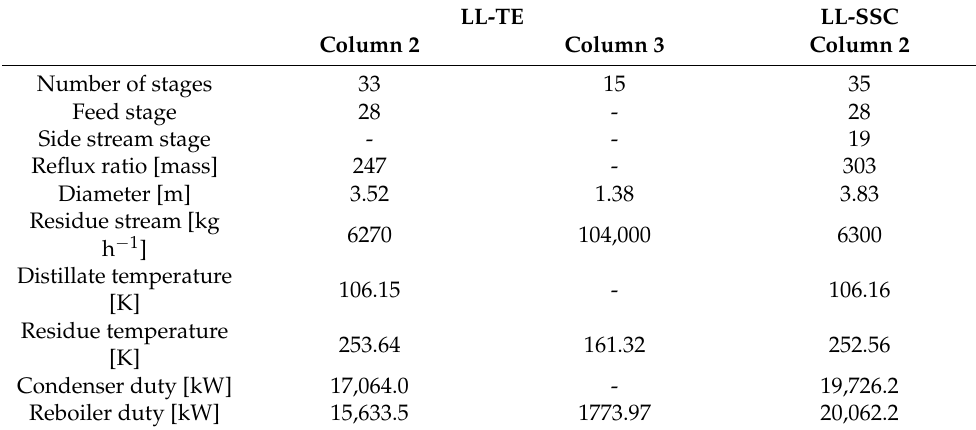
Table 5. Design parameters and operative variables for the configurations LL-TE and